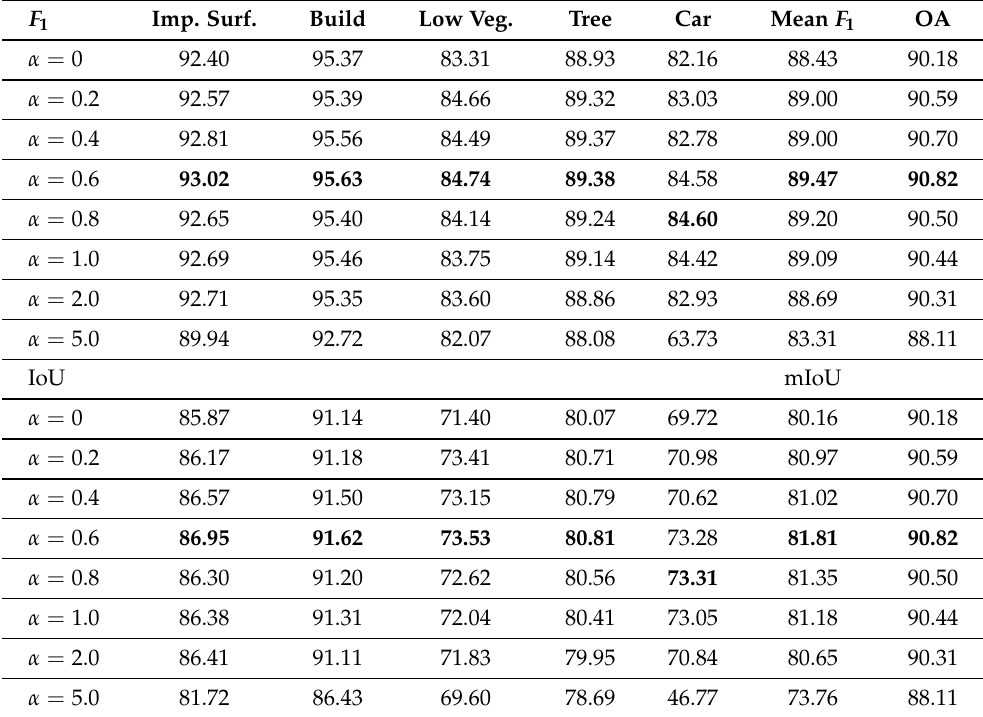
Table 7. Ablation study for weight parameter α .